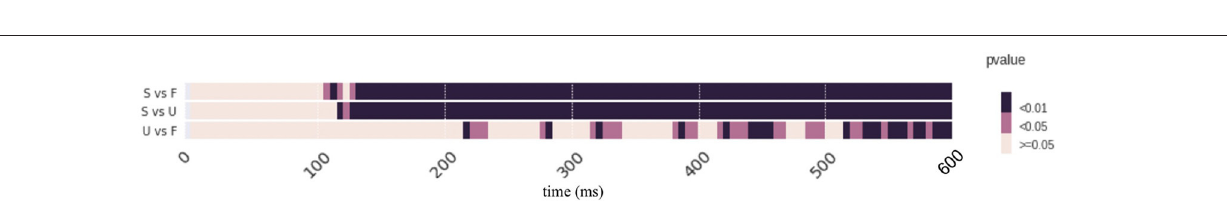
FIGURE 3 | Results of TANOVA analysis. The results are represented as p -values across time. Color represents the significant levels, with darker color for smaller p -values. Conditions labels are the same as in Figure 1 . (A–C) The results obtained by applying different strategies of computing null distribution in the non-parametric tests. These results are similar. The topographic response patterns in condition “Scrambled” starts significantly different from those in the face perception conditions after 170ms and last till the end of epoch. For comparison between face perception conditions (F vs U), significant pattern differences are obtained after 470ms. Results in Strategy 3 have an exception that all three comparisons show significant differences for a short time period around 180ms. Refer to main text for detailed results.